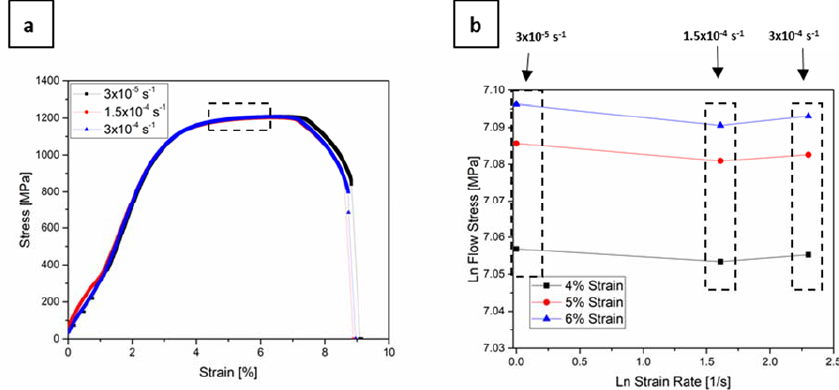
Figure 3. ( a ) Stress-strain curves of CP 1200 steel tested strain rates of 3 × 10 − 5 s − 1 , 1.5 × 10 − 4 s − 1 , and 3 × 10 − 4 s − 1 ; ( b ) ln flow stress-ln strain rate plot for the strains indicated in the box in ( a ), showing no significant strain rate sensitivity.